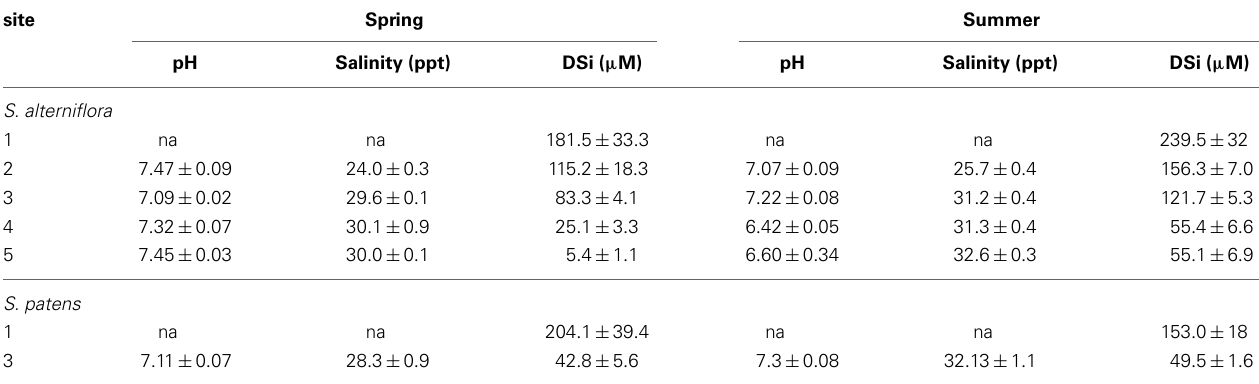
Table 4 | pH, salinity, and DSi concentrations (average ± standard error) measured in top 30cm of porewater at each marsh site in this study.